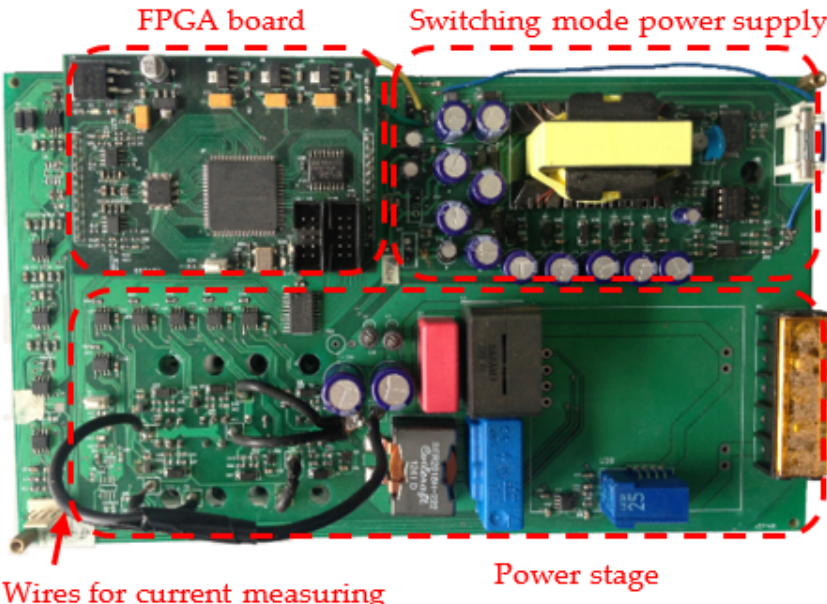
Figure 14. Photograph of the prototype.